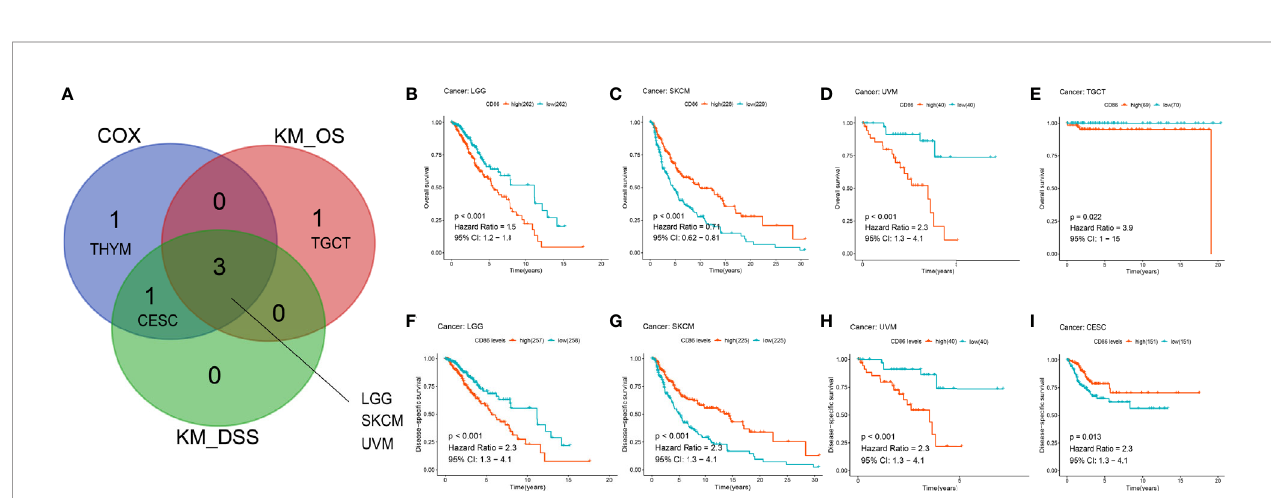
FIGURE 2 | Forest plots of cox regression analysis with CD86 expressions in different cancer types. (A) Overall survival (OS). (B) Disease-speci fi c survival (DSS). Cancer types with statistically signi fi cant prognostic value of CD86 in both OS and DSS are highlighted in